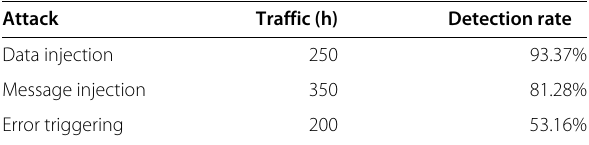
Table 4 Detection results for adversarial evasion Attack Traffic (h) Detection rate Data